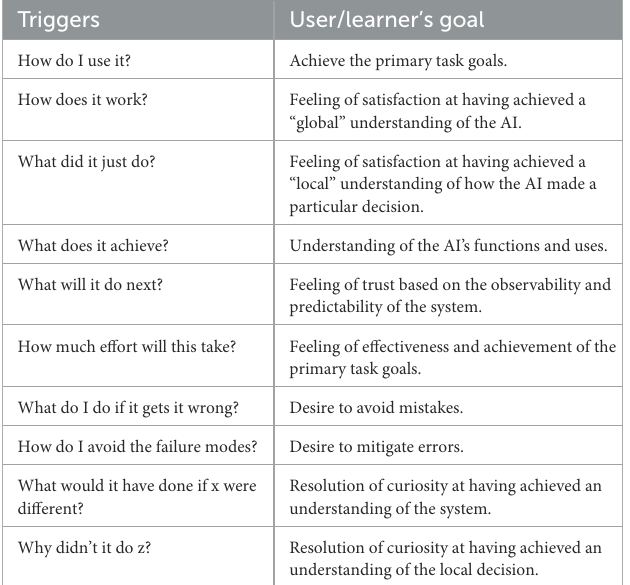
TABLE 1 Triggers of the need for explanation, and corresponding learner’s and goals. Triggers User/learner’s